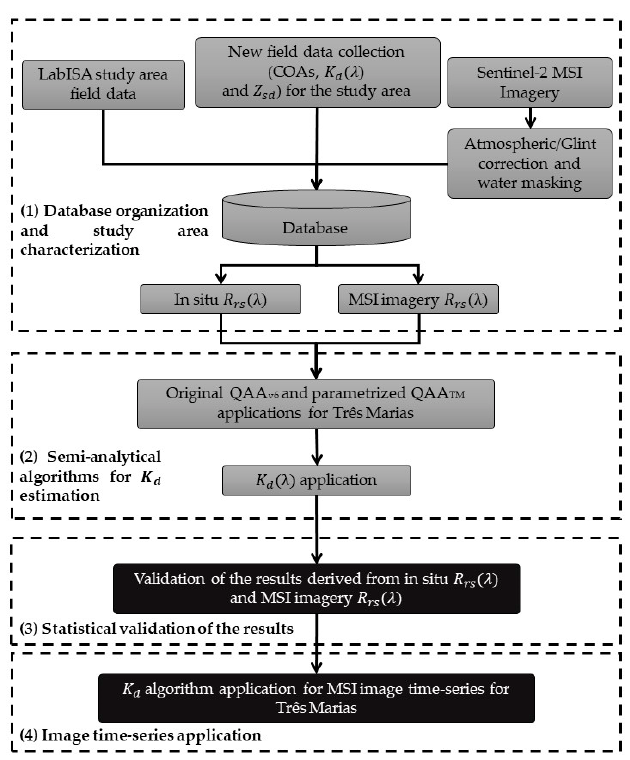
Figure 1. Materials and methods flowchart. LabISA stands for Instrumentation Laboratory for Aquatic Systems (in Portuguese).